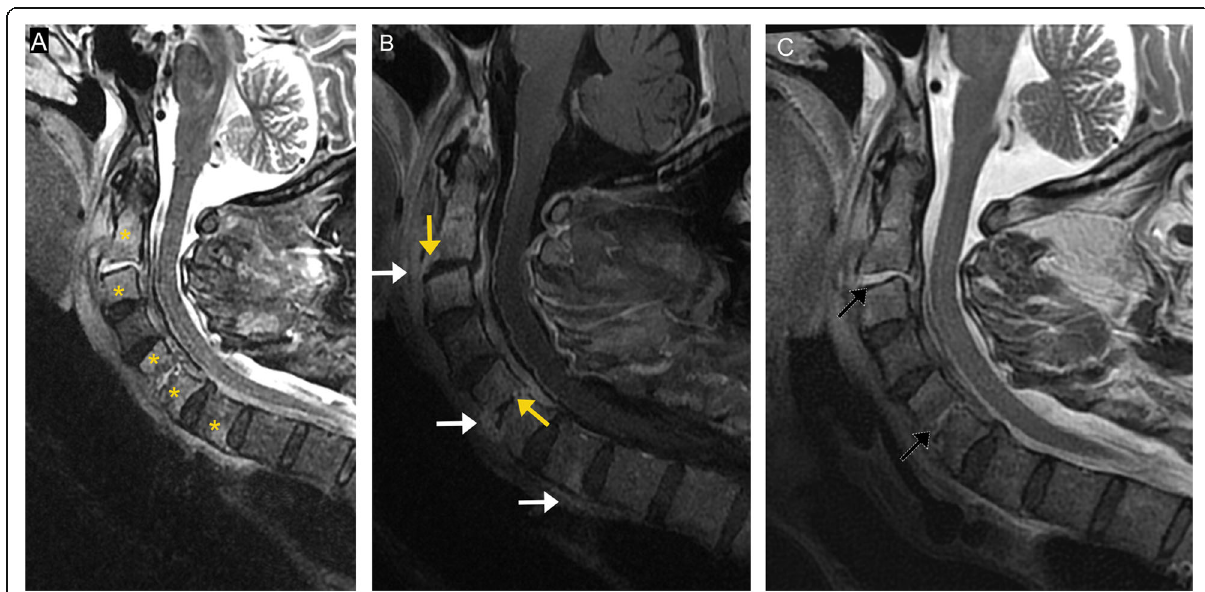
Fig. 13 Pyogenic spondylodiskitis. Sagittal STIR image ( a ) demonstrates abnormal marrow signal of C2, C3, C5, C6, and C7 (asterisks) with diffuse paravertebral soft tissue edema. Post-contrast T1-weighted image ( b ) demonstrates corresponding marrow enhancement, disc enhancement, and endplate erosion (orange arrows). Phlegmon or abscesses are seen at the level of C2-C3, C5-C6, and C6-C7 (white arrows), as well as